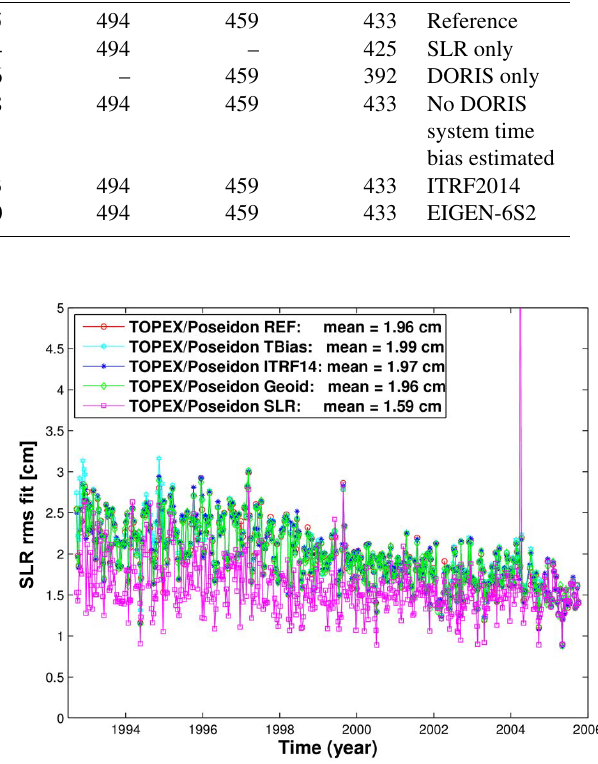
Figure 1. SLR rms fits of TOPEX/Poseidon REF, SLR, TBias, ITRF14, and Geoid